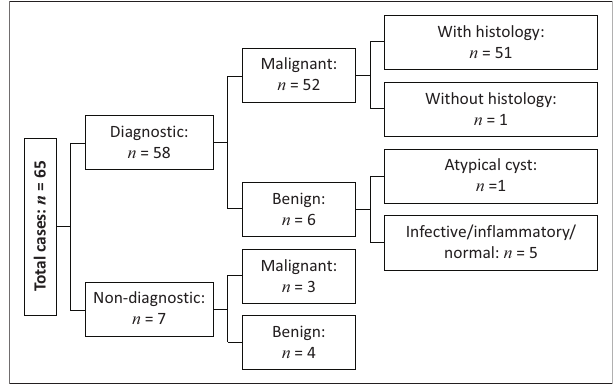
FIGURE 1: Breakdown of FNAB with ROSE